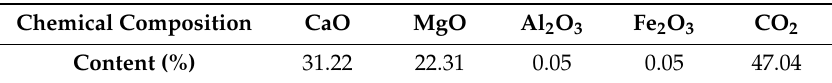
Table 3. Chemical composition of